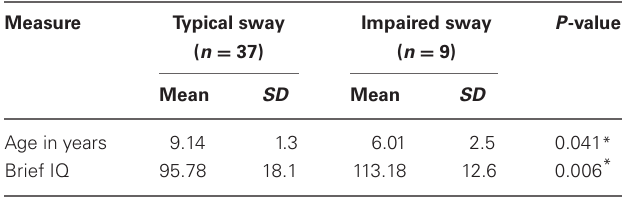
Table 2 | Means and standard deviations (SD) for Non-verbal IQ and age for groups based on postural stability.